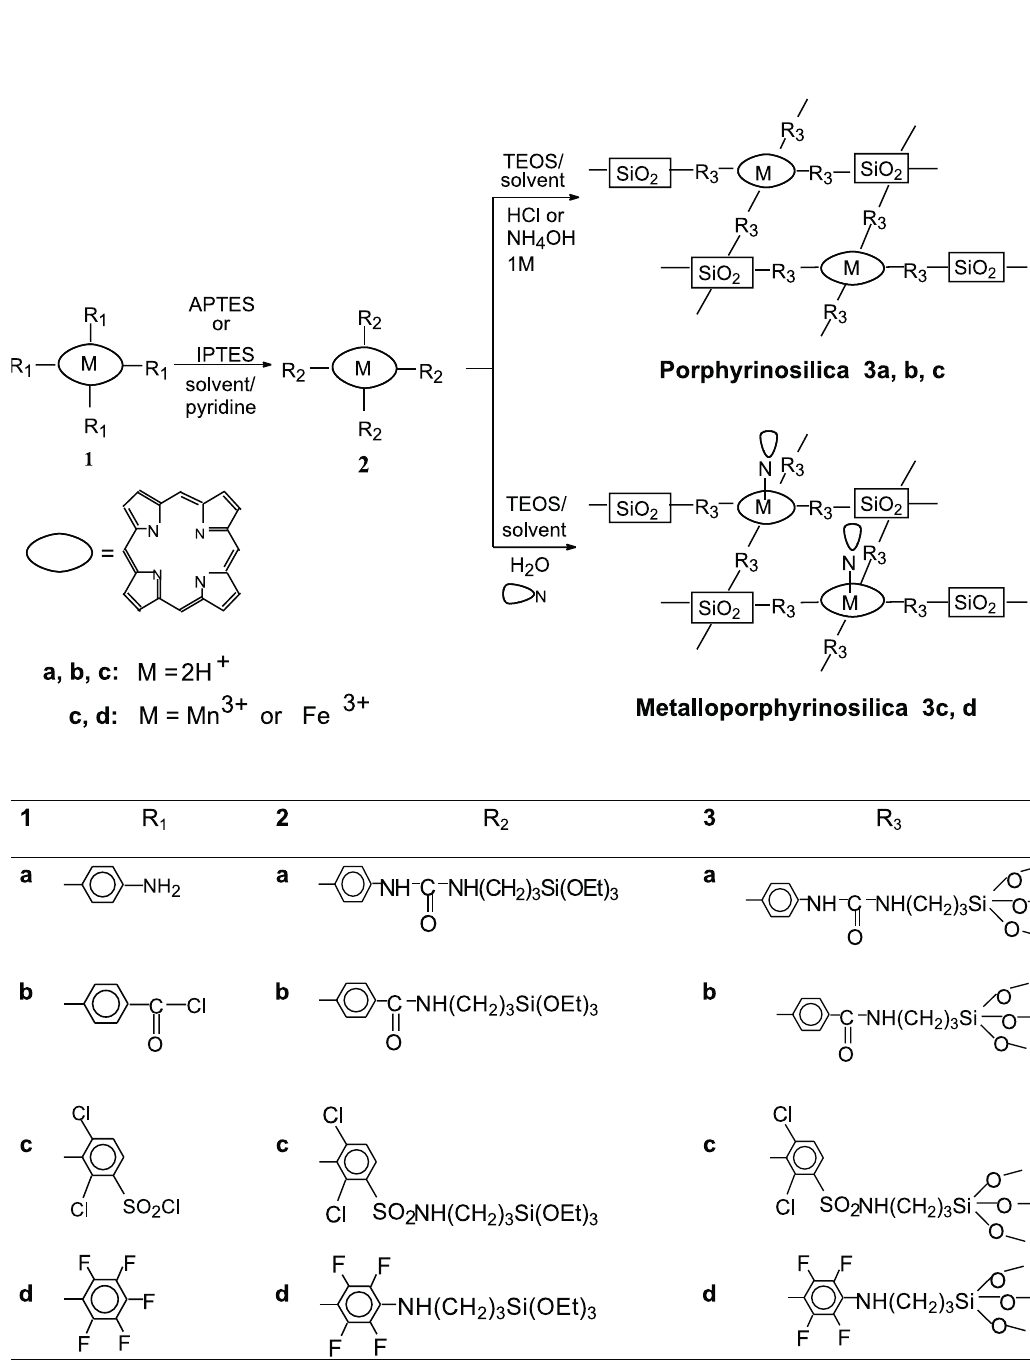
Fig. 1 – Synthesis of MPS. Template =